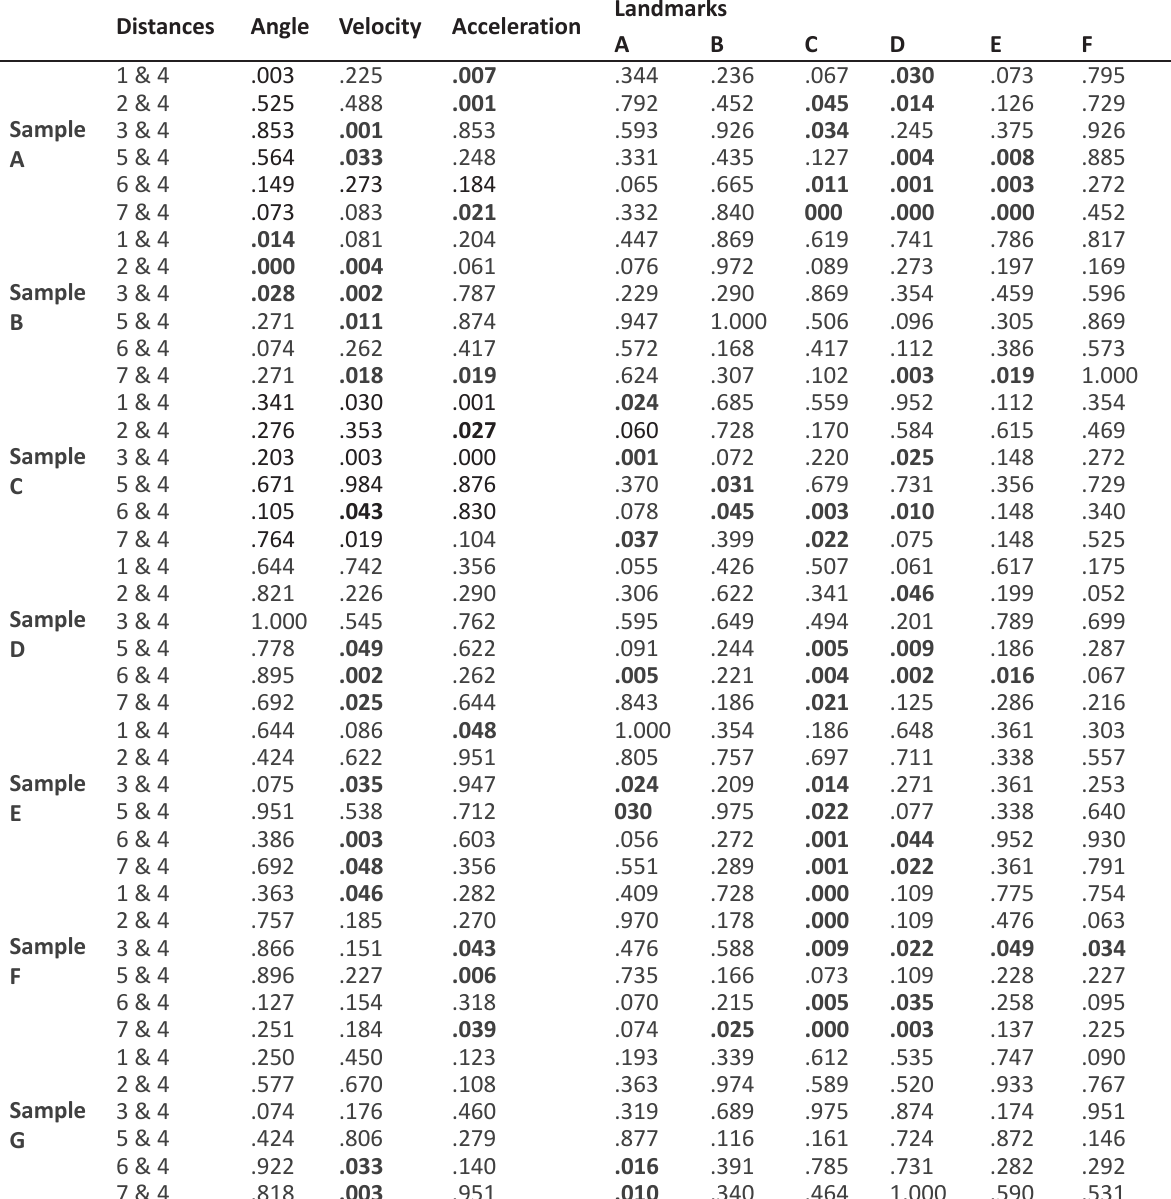
Table 1. Differences between three kinematic variables and relative timing landmarks A-F of distance 4 and other 6 distances in all samples calculated by ANOVA and U Man Whitney tests which selected based on the normality test results. Significant value is shown at 0.05 level with bold